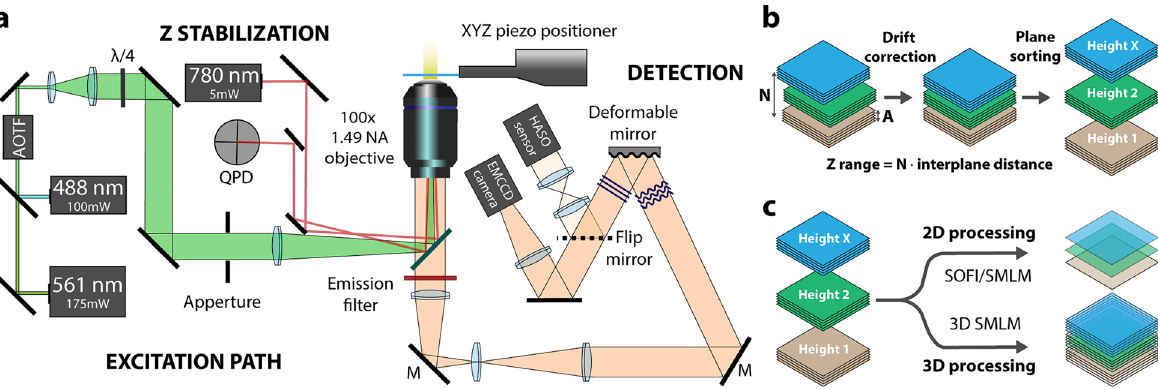
Figure 1: Schematics of the optical setup and image processing pipeline. (a) Sample excitation was achieved by two continuous laser sources with independently modulated power by acousto-optic tunable filter. Laserbeamswerethenexpandedwithatelescopeandfocusedbyalensintothebackfocalplaneofthe100 × NA=1.49oilimmersionobjective to achievea wide fi eldilluminationof thesample.Fluorescence lightwas collectedbythe sameobjectiveand fi lteredusingacombinationof a dichroic mirror and two emission fi lters. The light is then passed through MicAO 3DSR adaptive optics setup which consists of a deformable mirror and a wavefront sensor. Light is then detected either by a wavefront sensor, which is used for a calibration of AO system or a water- cooled EMCCD camera with a back-projected pixel size of 105 nm. Total internal re fl ection of an infrared laser is used to axially stabilize the sample which is precisely positioned by the XYZ piezo stage thuseliminating the axial drift. (b) 3D image stacks wererecorded by shifting the height using a deformable mirror every A number of frames in order to homogenously distribute bleaching in all the N planes. Fluorescent beads immobilized on a coverslip were imaged every A number of frames with a 488 nm laser line and then used for lateral drift correction (SI driftcorrection).For fi nalprocessingimagestacksweresortedbasedonfocusvaluesappliedforeachframe.(c)Substackswereprocessedby using SOFI and SMLM routines published previously as described in Section